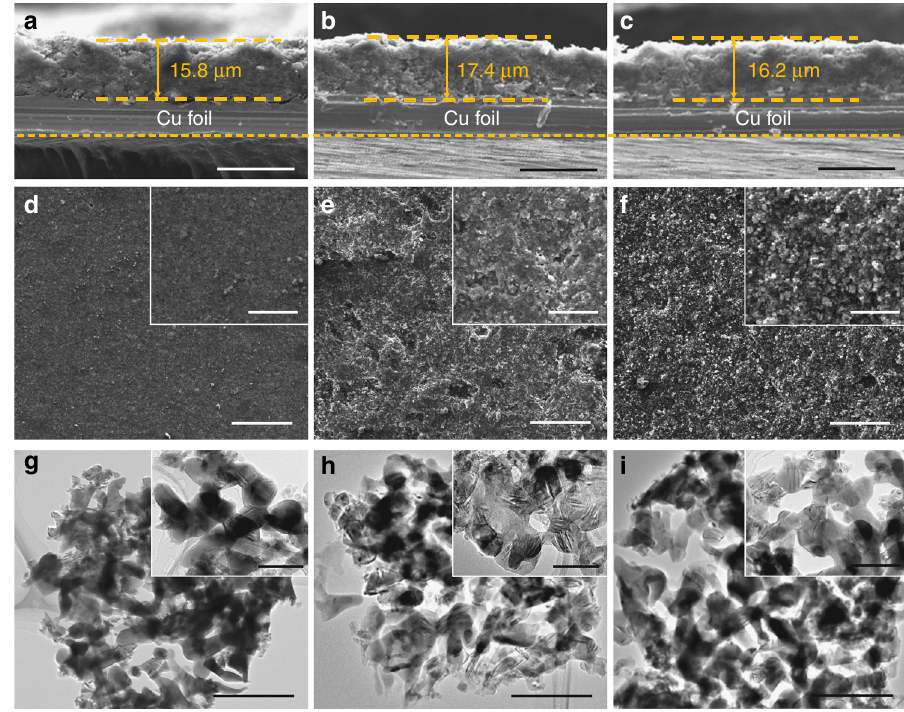
Fig. 5 Electrode swelling measurements of AMPSi@C. Cross-sectional SEM images of the AMPSi@C electrode fi lms a before cycling, b after full lithiation, and c delithiation, respectively (scale bar for a , b , and c = 20 μ m). d – f Corresponding top-view SEM images (scale bar for d – f = 100 μ m and scale bar for